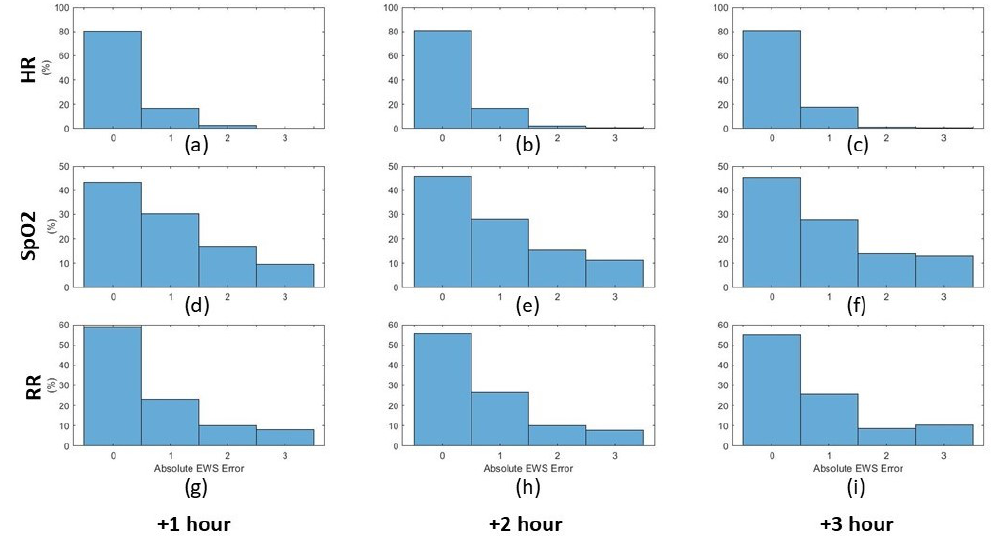
Figure 12. Normalised histograms of the absolute EWS error of the predicted values for the three vital signs for the upcoming three hours based on the observation rate of one observation/5 min. Each row represents one of the three vital signs: heart rate, oxygen saturation, and respiration rate, respectively. Each column represents the prediction hour: +1, +2, +3 h, respectively. ( a ) HR +1 h, ( b ) HR +2 h, ( c ) HR +3 h, ( d ) SpO 2 +1 h, ( e ) SpO 2 +2 h, ( f ) SpO 2 +3 h, ( g ) RR +1 h, ( h ) RR +2 h, ( i ) RR + 3